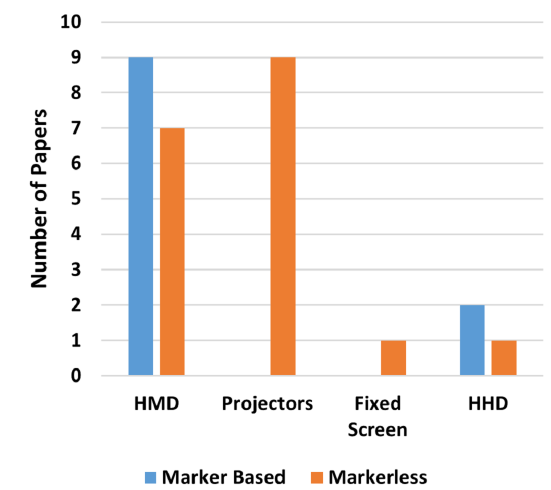
Figure 21. ( A ) Tracking methods over time; ( B ) tracking methodology by papers.